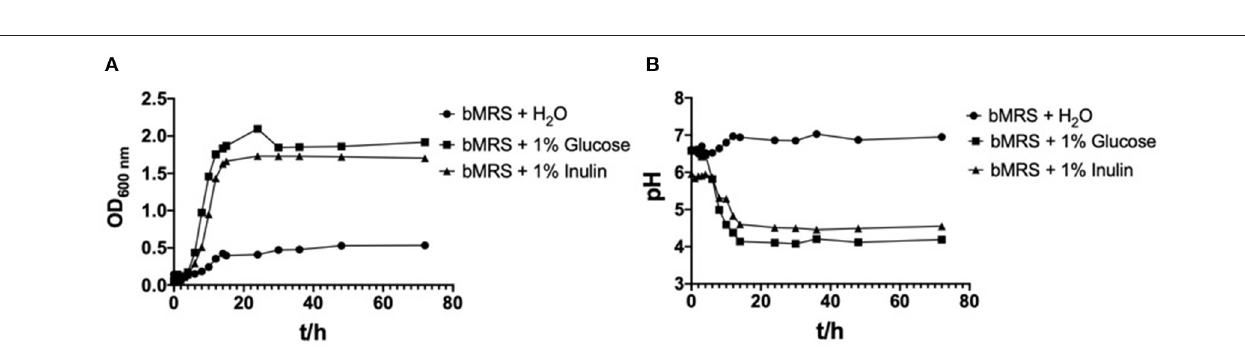
FIGURE 2 | Growth curves of strain Lacticaseibacillus paracasei YT170 in bMRS medium containing 1% inulin and 1% glucose (A) and the pH change (B)